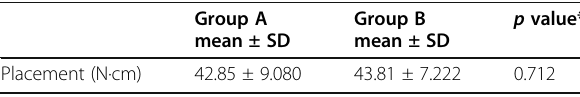
Table 5 Mean IT values at